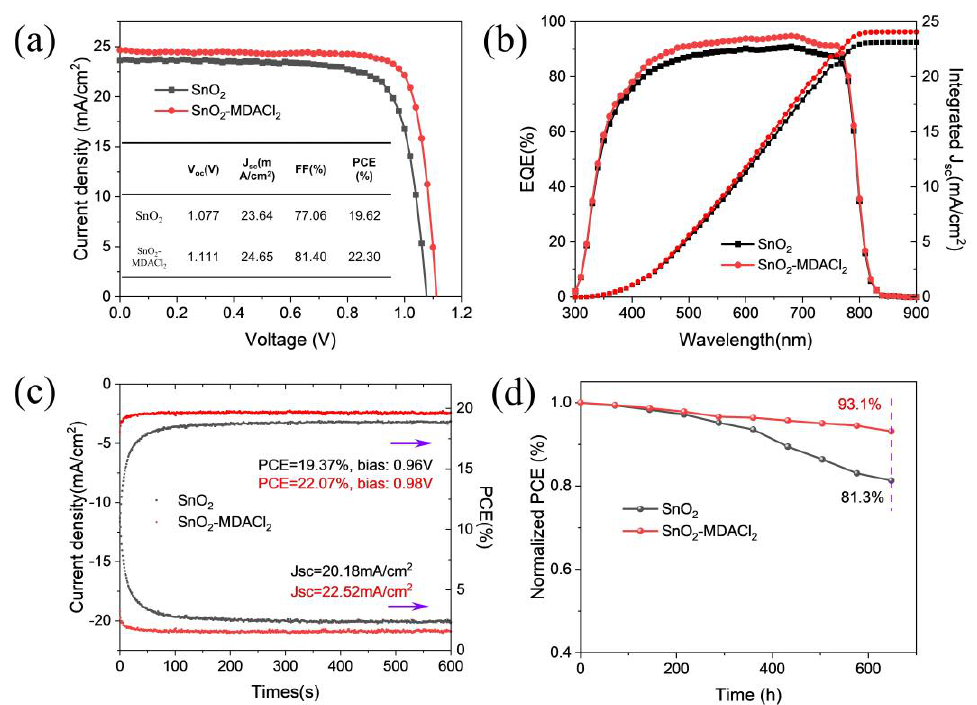
Figure 5. ( a ) J–V curves of the champion devices based on SnO 2 and SnO 2 -MDACl 2 substrates under reverse scan. ( b ) EQE spectra and the integrated current density of the PSCs. ( c ) Stable power output curves of the PSCs measured at the maximum power point under AM 1.5G illumination in glovebox. ( d ) Long-term stability performance of the unencapsulated PSCs under conditions of RH: 35%, T: 25 °C.